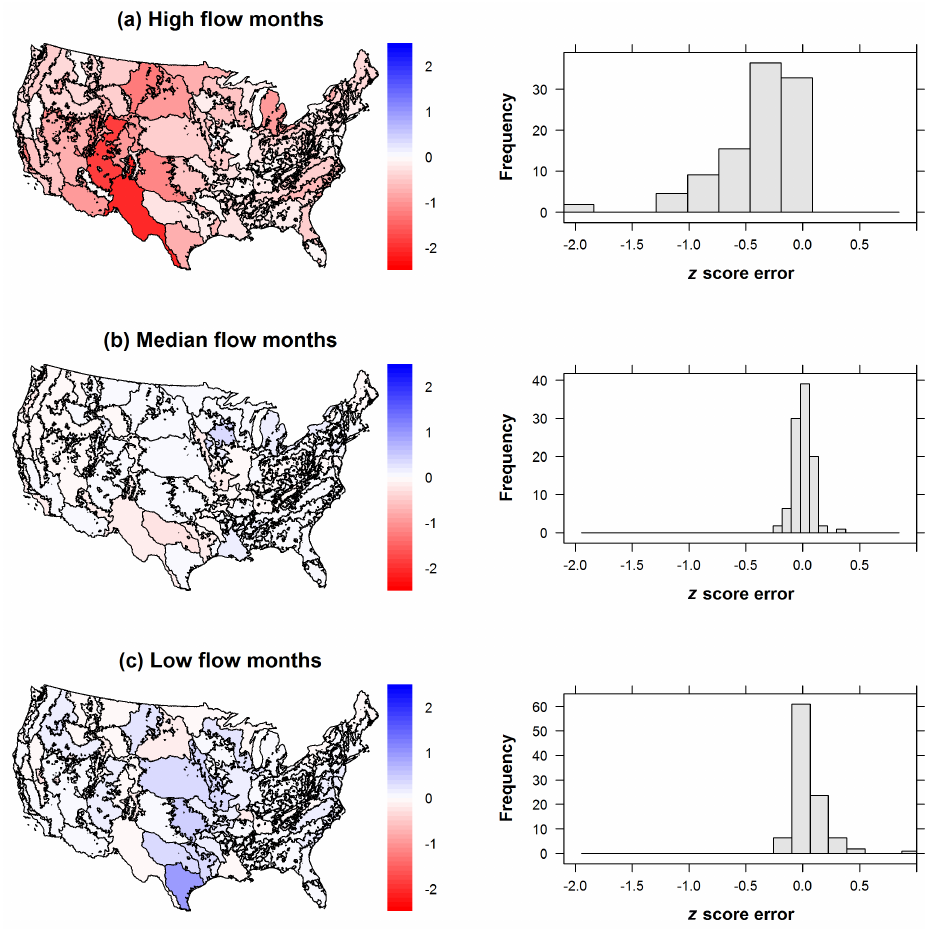
Figure 12. The z score error (simulated–measured) for (a) highest-, (b) median-, and (c) lowest-flow months.